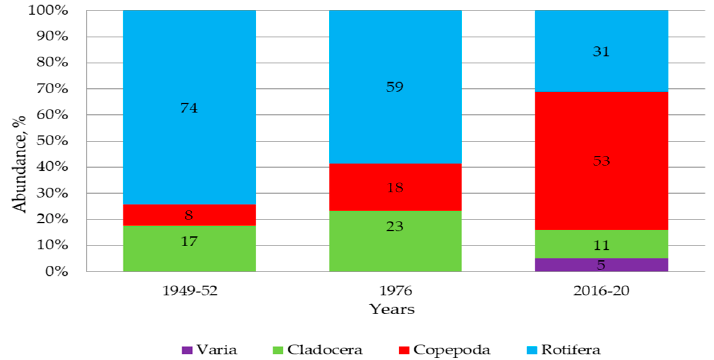
Figure 16. Long-term changes in zooplankton community structure in the Lower Dniester (1949–1952 according to [7], 1976 according to [12], 2016–2020 according to [4,5] and project data).